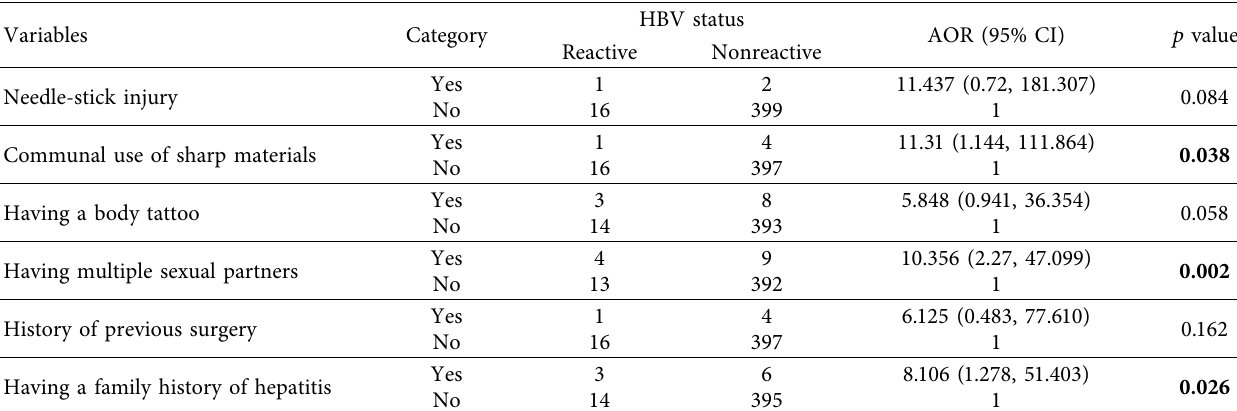
Table 6: Multivariate analysis for factors associated with HBV among blood donors at Bahir Dar Blood Bank centre, Northwest Ethiopia, 2020 ( n �